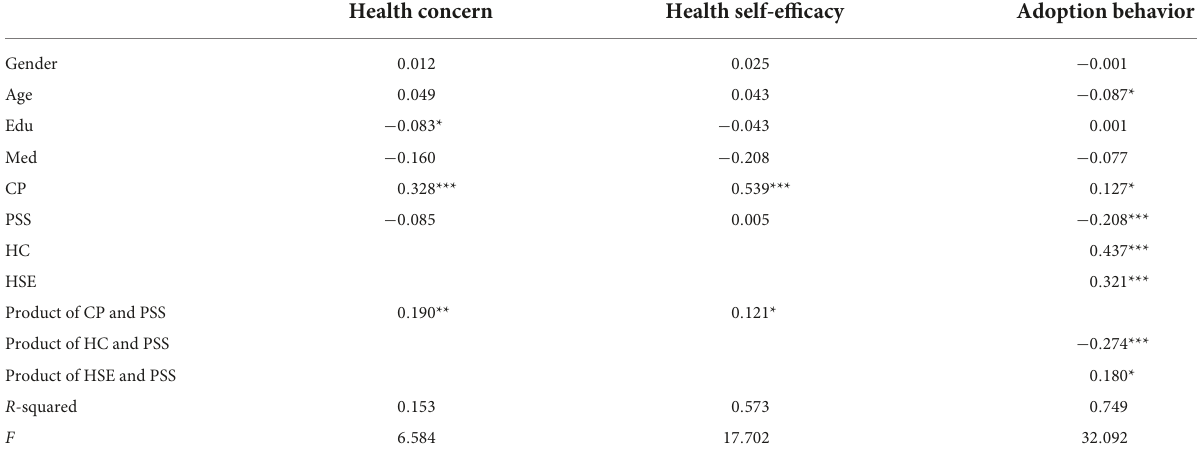
TABLE 8 Test for the mediating effect of health concern and health-related self-efficacy moderated by perceived self-esteem support.